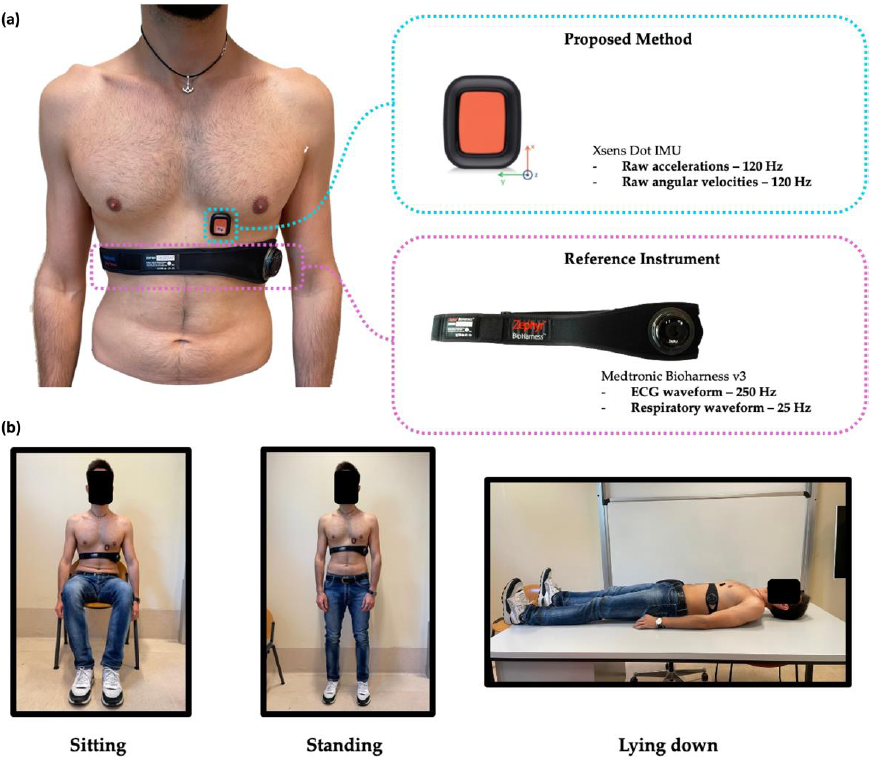
Figure 2. ( a ) Positioning of the IMU sensor at the fifth-left intercostal space in the midclavicular line of the mitral valve and of the wearable chest multiparametric device used as a reference system for registering both the ECG waveform and the respiratory waveform. ( b ) Picture of one subject during the protocol performed in the 3 at-rest postures, i.e., sitting, standing, and lying down.